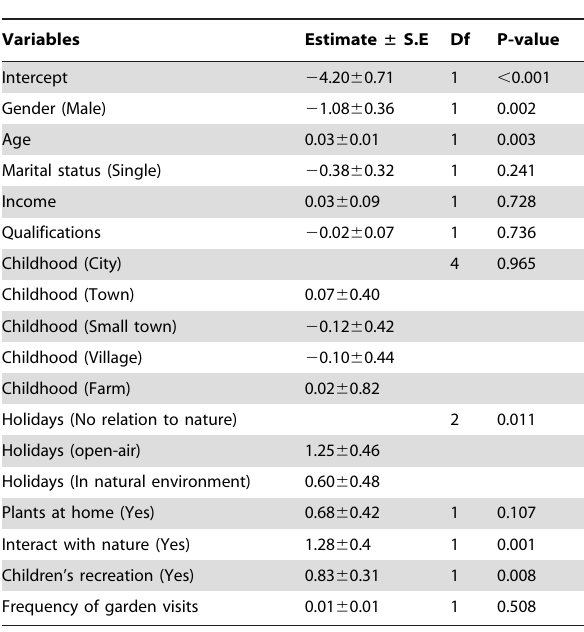
Table 3. Results of the general linear model with binomial error structure comparing differences between the social and pro-environmental profiles of people who came to the activity (participants; n =69) to people who visit the gardens on a day-to-day basis (general visitors; n=